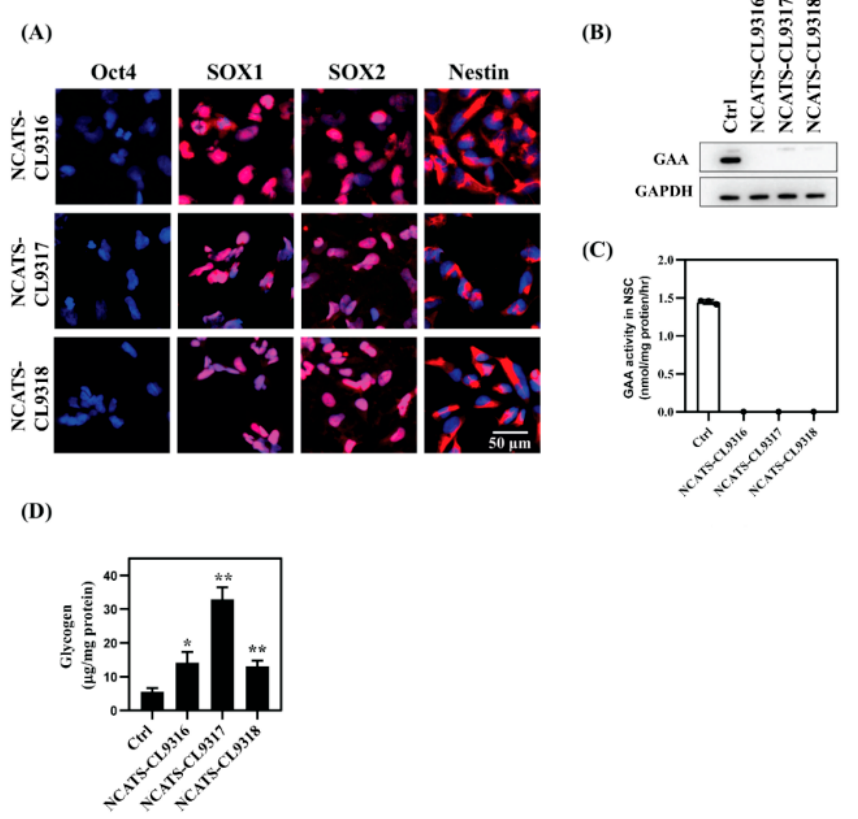
Figure 1. Characterization of Pompe disease patient-derived neural stem cells (NSCs) ( A ) Immunofluorescent staining of Pompe disease NSCs showing positive staining of neural markers (SOX1, SOX2, and Nestin) and negative staining for the pluripotency marker, Oct4. Blue staining indicates nuclear (Hoechst) staining. ( B ) Western blot analysis of GAA protein levels in control (Ctrl) versus Pompe disease NSCs. ( C ) GAA activity assays using 4-MU substrate in control and patient NSCs. ( D ) Total amount of cellular glycogen of control and patient NSCs. Error bars represent SEM of three independent experiments (* p < 0.05 and ** p < 0.01 by t -test).